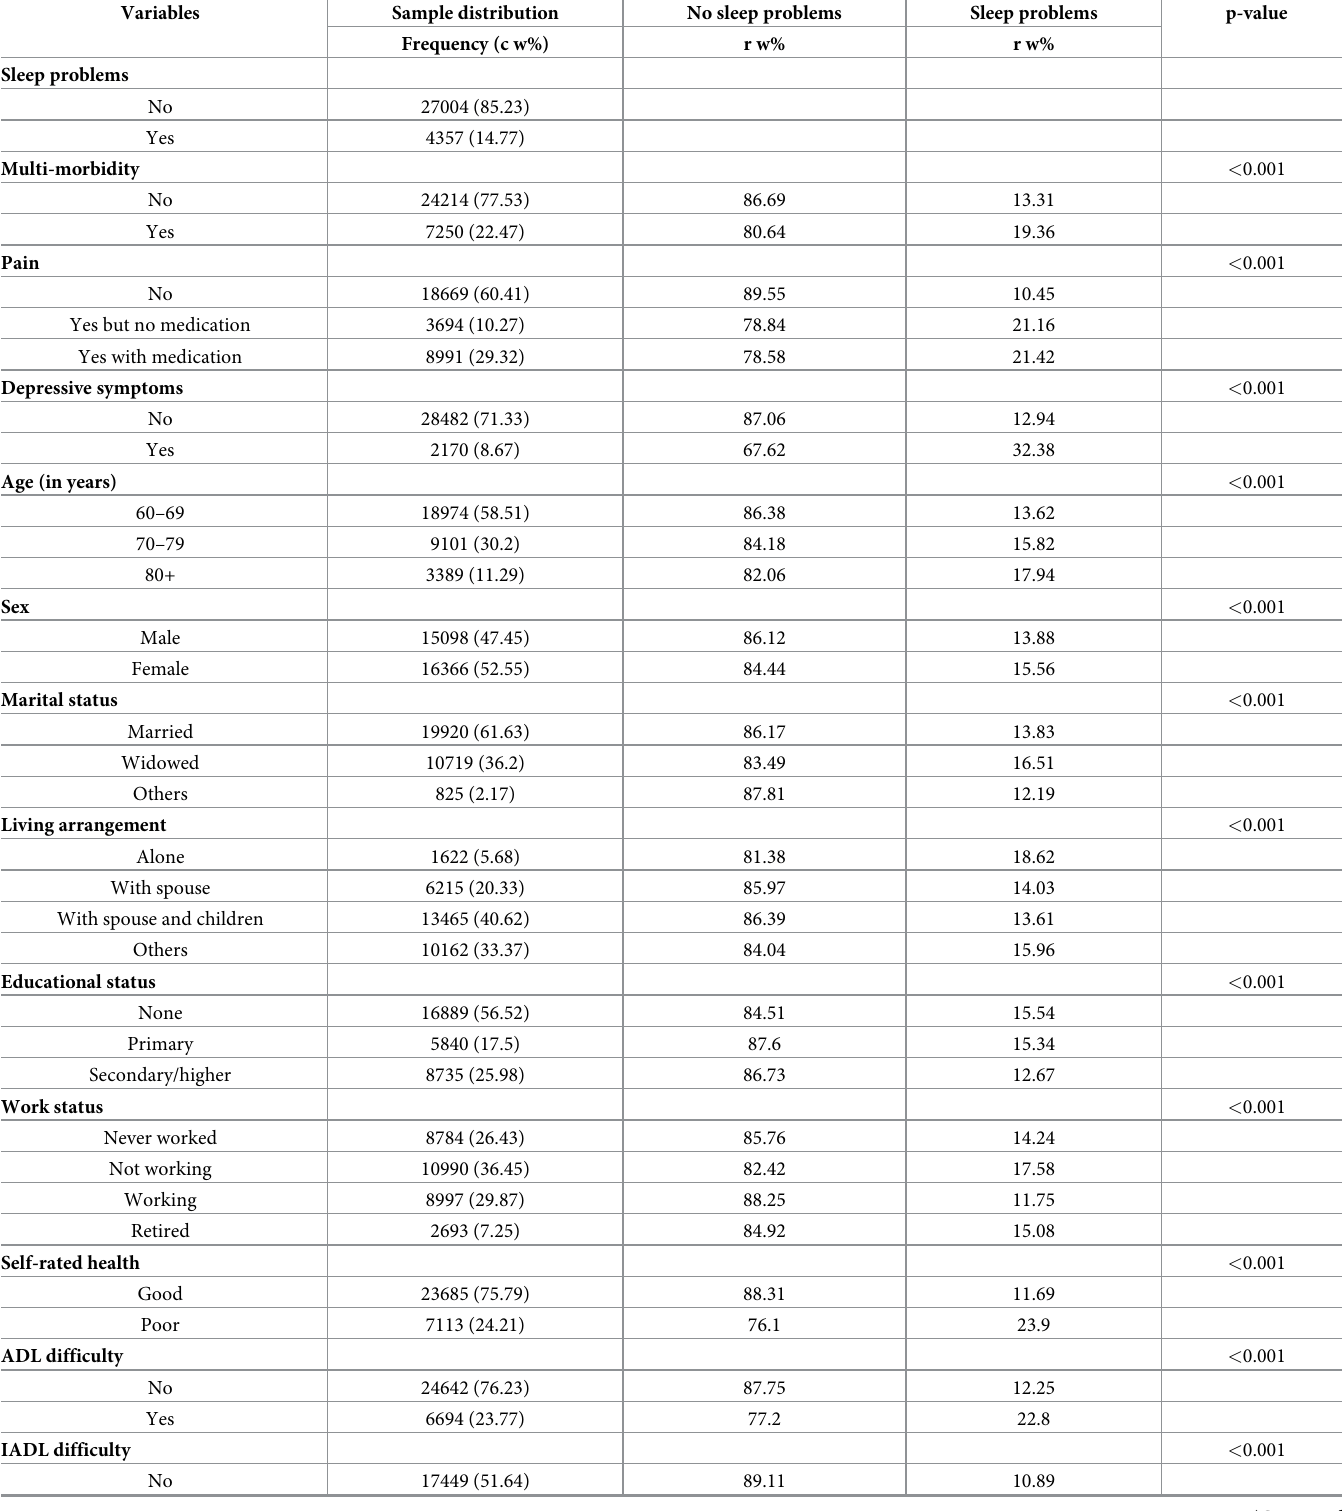
Table 1. Sample distribution and rates of sleep problems by background characteristics among older adults (n =